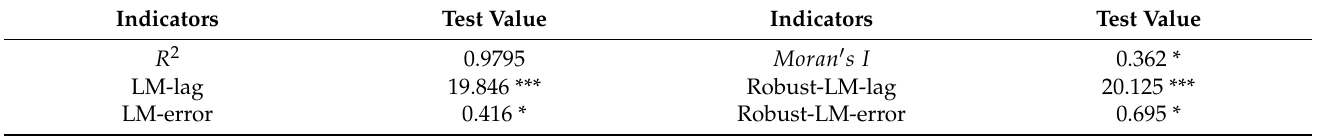
Table 3. LM test of the non-spatial interactive fixed effects